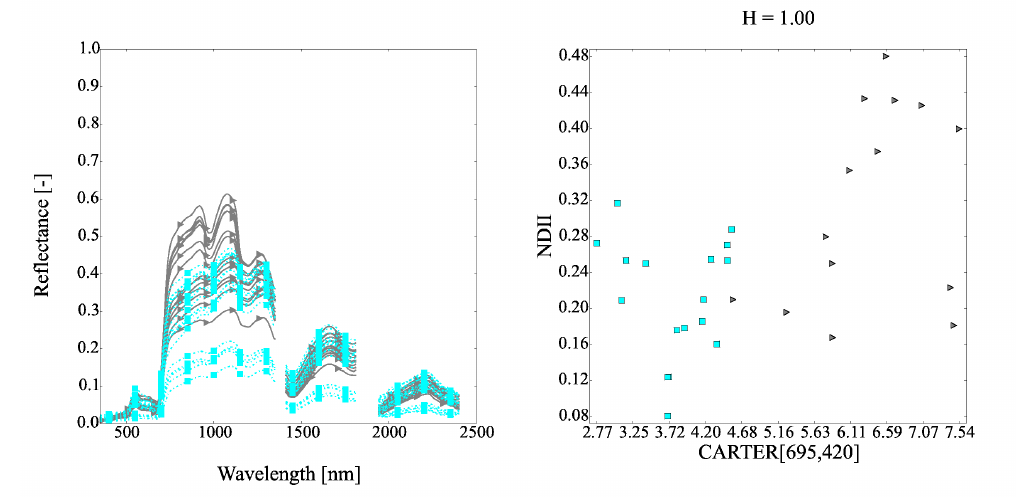
Figure 12. ( Left ) spectral signatures of CAVU (gray) and Salix sp. (SALI) (cyan); ( Right ) map of CARTER[695,420] and Normalized Difference Infrared Index (NDII) values for each vegetation type, H is the Hellinger distance.